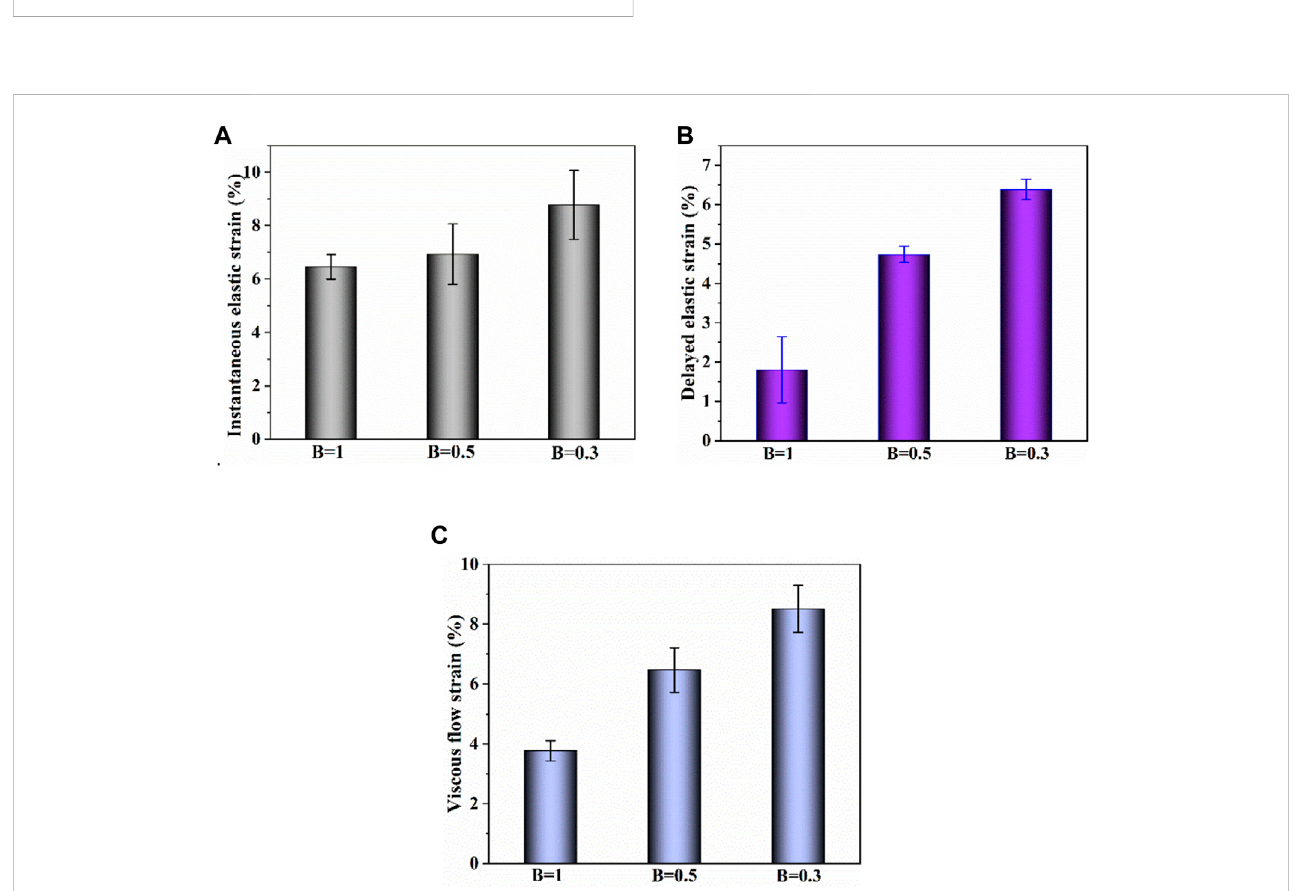
FIGURE 10 (A – C) Instantaneous elastic strain, delayed elastic strain and viscous fl ow strain components of biaxial creep strain, respectively.